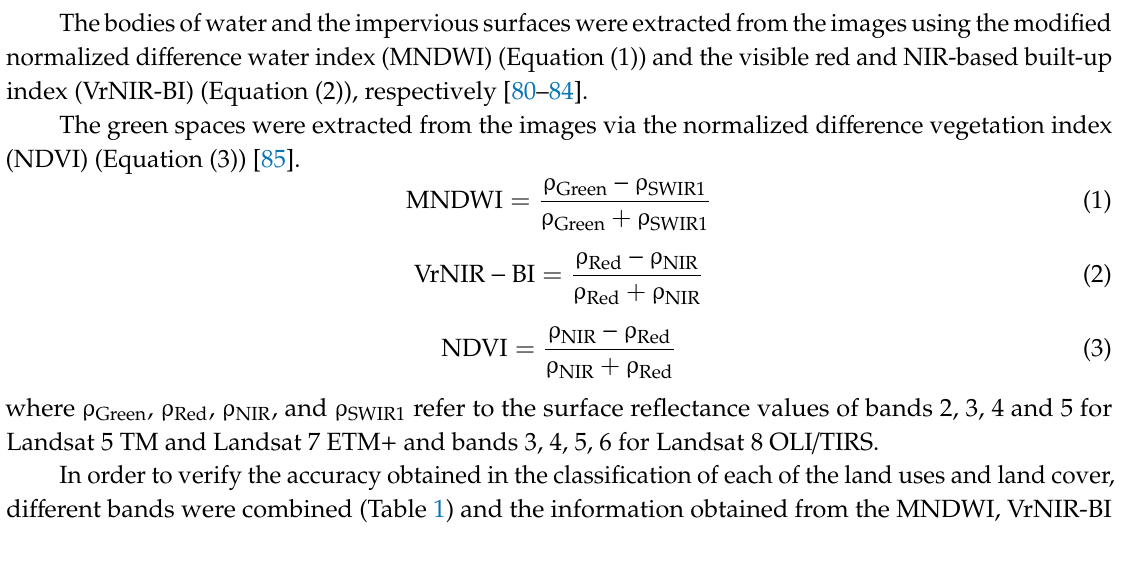
Figure 3. Land cover maps of Seville City and its immediate surrounding areas derived from Landsat imagery (1987, 2002, 2017).